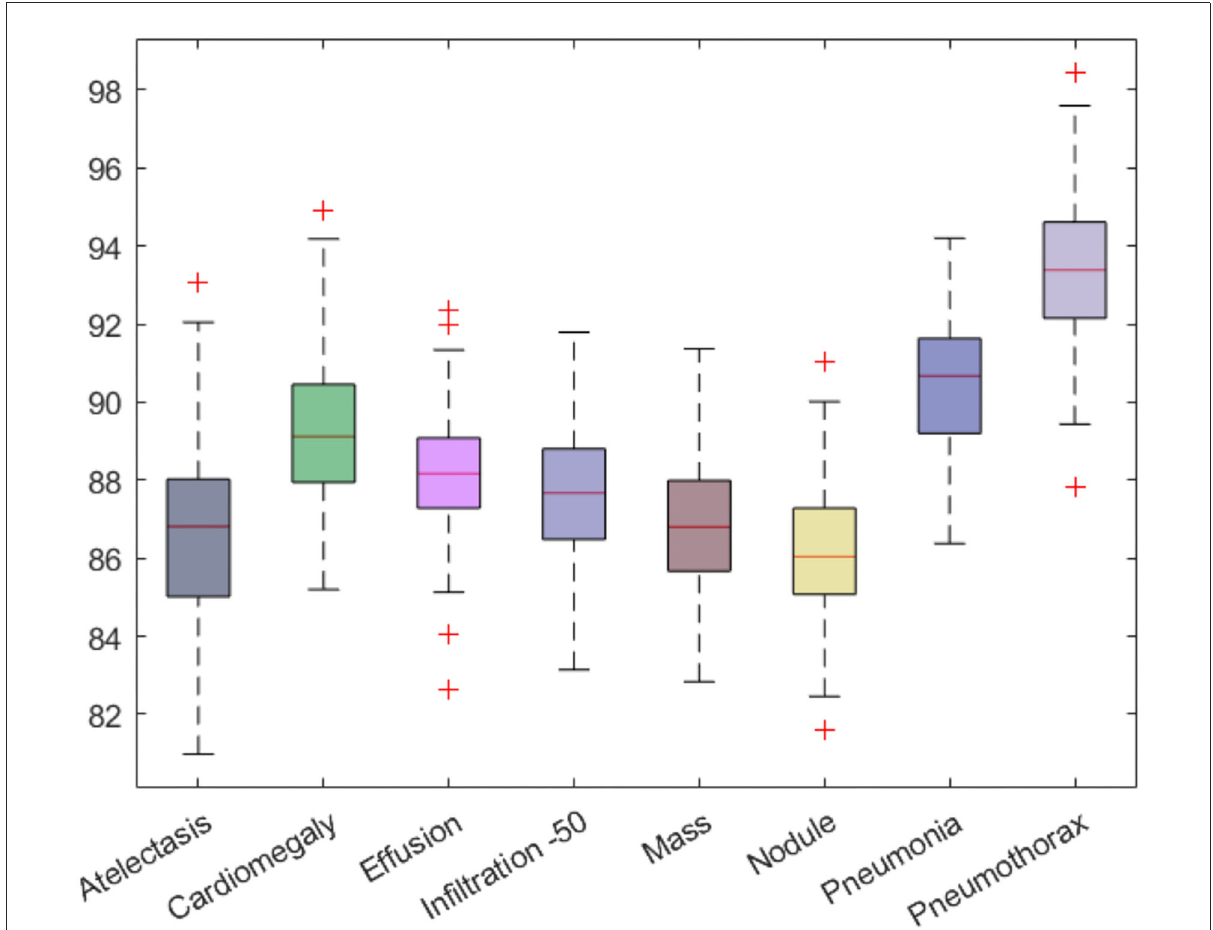
FIGURE10 Class-wise precision values for the custom CenterNet